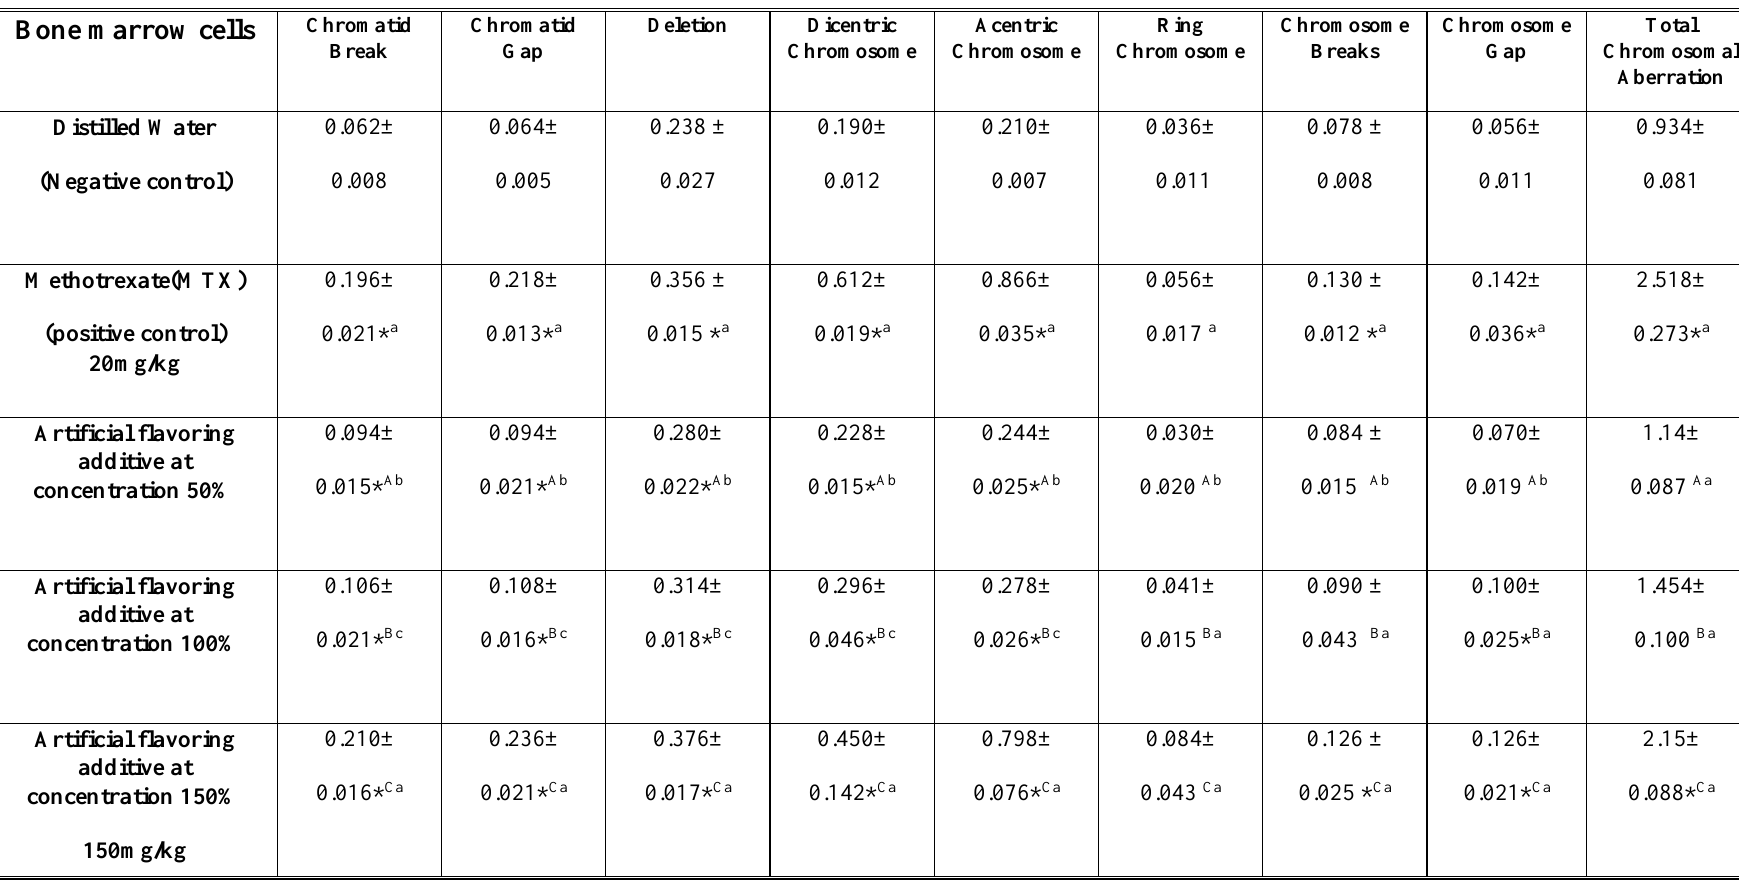
 Data are expressed as mean±S.D; n=6 animals in each group;  *significantly different compared to distilled water (negative control) ( P <0.05);  Values with non-identical small letters superscripts (a,b,c) consider significant different when compared with methotrexate (positive control) ( P <0.05).  Values with non-identical capital letters superscripts (A,B,C) Significant different when compared between tests groups ( P